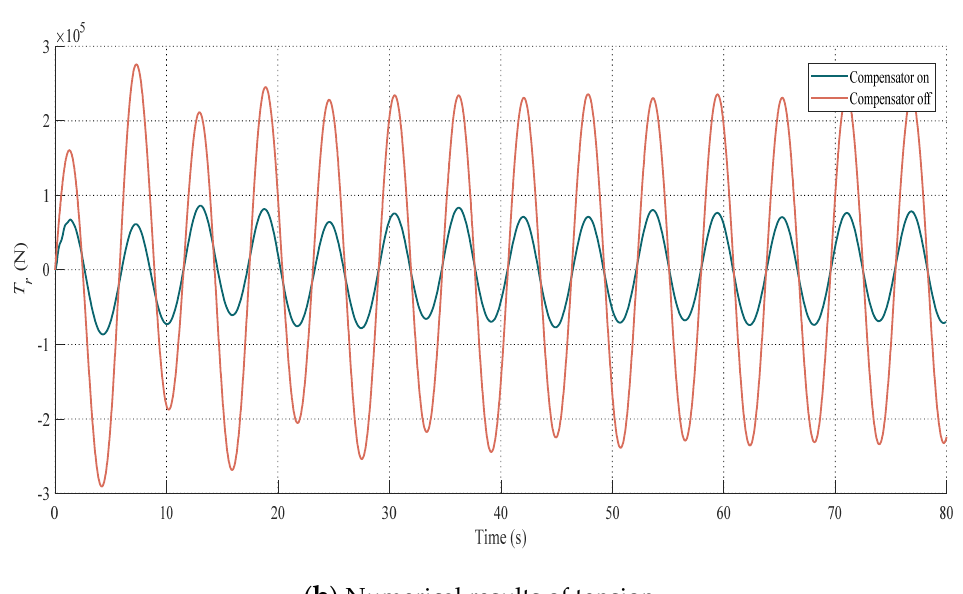
Figure 10. Numerical results. The compensator had a nonlinear damping feature due to the flow characteristic of the pipeline. The influences of damping characteristics on the compensator efficiency and dynamic tension were studied for the various diameters of the pipeline, as shown in Figure 10. In Figure 11, responses were plotted for 3 different diameters d t of pipeline. As the pipeline diameter increased, the corresponding amplitude values of y p and T r decreased. This indicated that the smaller damping values were better since the damping value decreased and the compensation efficiency increased with increasing the diameter of the pipeline. The reason for increased compensation efficiency was that the smaller damping force produced a smaller time delay to the